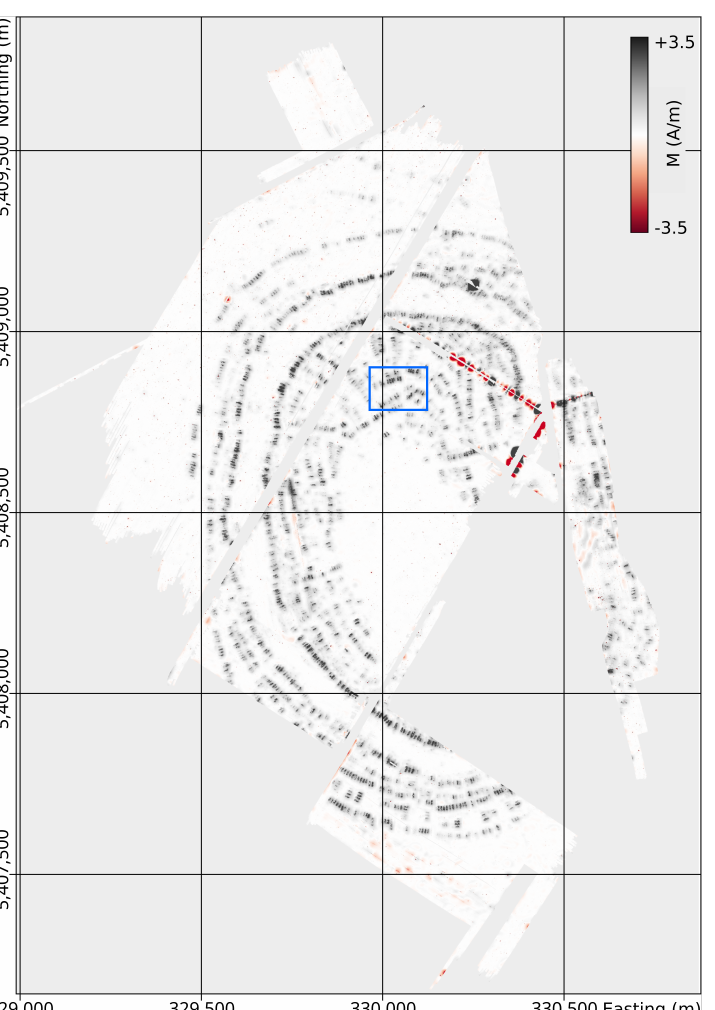
Figure 9. Magnetization distribution of Maidanetske derived by inverse filtering. The blue box marks the area shown in Figure